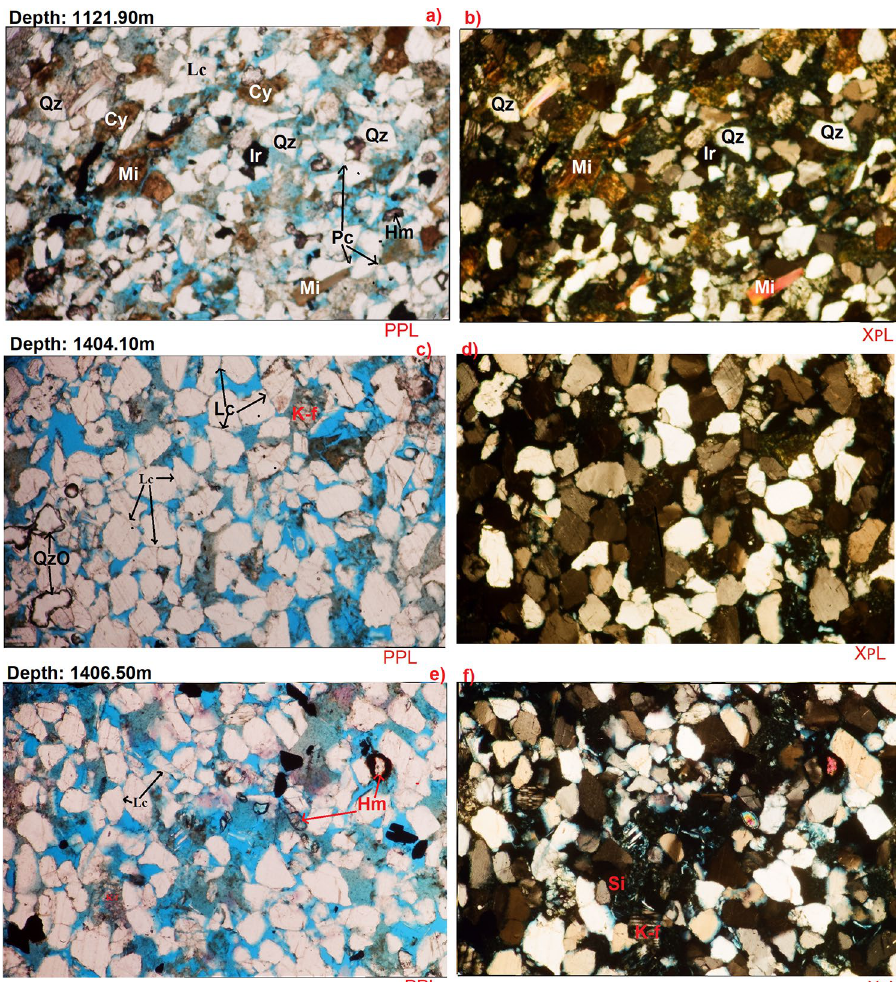
Figure 9. ( a – f ) Fine to grained, well sorted, sub rounded to sub angular, patchy cemented, and moderately compacted with point, concavo-convex and long grain contacts Sub Feldspathic Arenite, common monocrystalline and polycrystalline quartz ( a – f ). Some quantities of mica ( a , b ) which arranged along the bedding plane due to the hydraulic fraction of the mica flakes as well as very few heavy minerals ( a , e ). Considerable amount of detrital clays occupying some pore spaces ( a , b ). Some quantities of iron oxides cement occur as pore filling ( a , b ), minor amount of quartz overgrowths ( c ) as well as with some amount of siderite ( f ). Qz quartz, QzO quartz overgrowth, Lc long grain contact, Pc point contact, Cy clay, Mi mica, Ir iron oxide, Hm heavy mineral, K‑f K-feldspars, Si